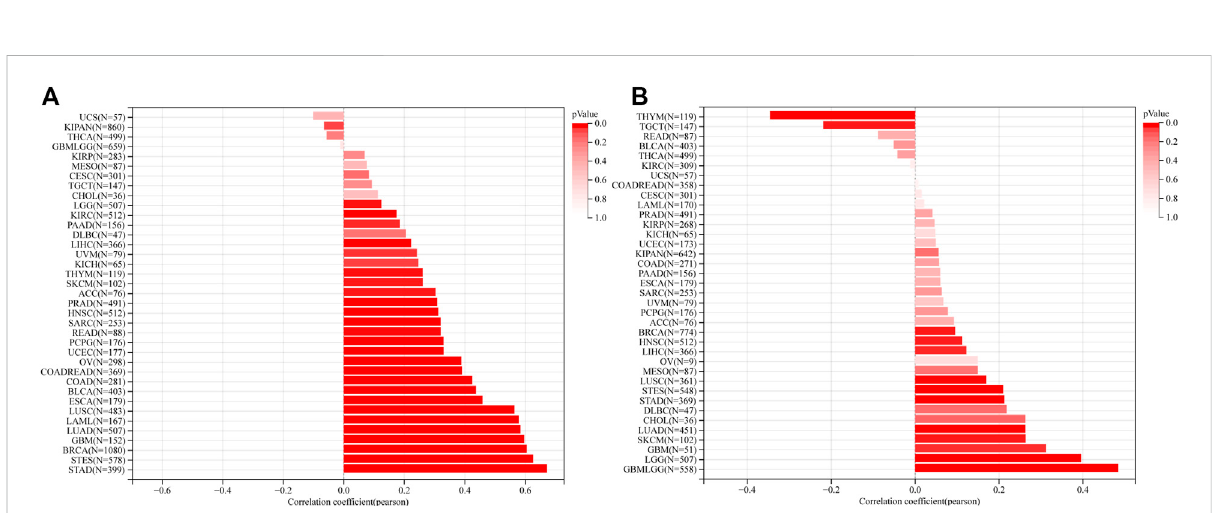
FIGURE 5 Correlation between RAD51AP1 expression and cancer stemness. (A) mRNAsi scoring analysis showed that RAD51AP1 expression positively related to cancer stemness in 27 cancer types. (B) mDNAsi scoring analysis showed that RAD51AP1 expression positively related to cancer stemness in 11 cancer types and negatively in THYM and